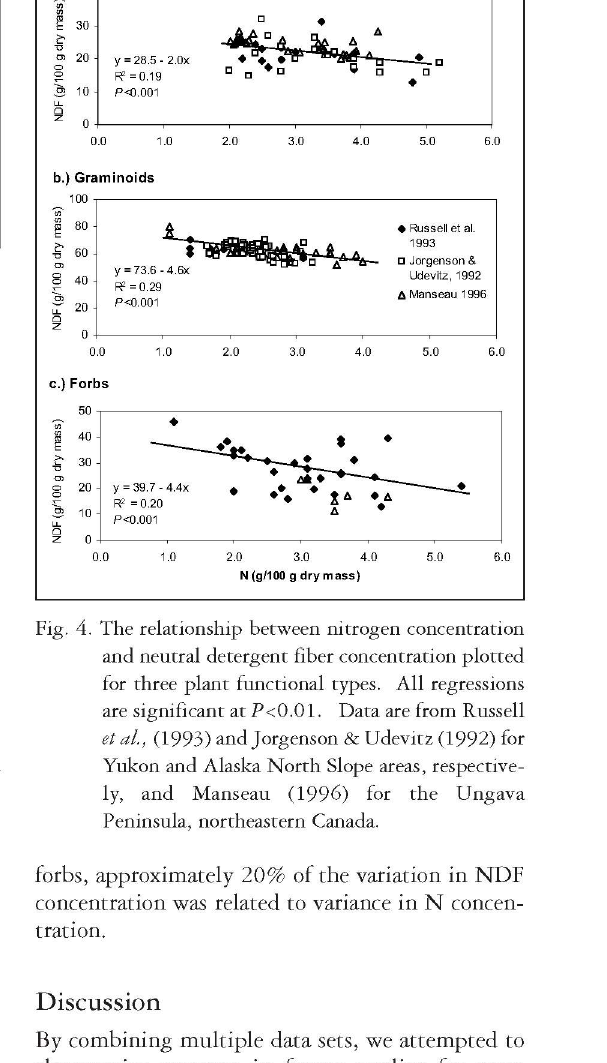
Fig. 3. The relationship between nitrogen concentration and in vitro dry matter digestibility (IVDMD) plotted for four plant growth forms (GRAM = graminoid, CFLR = cottongrass flower, DECD = deciduous shrub, FORB = forb). Data for graminoid leaves and cottongrass flowers are ana lyzed together. NS denotes a non-significant relation between N concentration and IVDMD for deciduous shrub data. Data are from the Arctic National Wildlife Refuge, Alaska (this study).